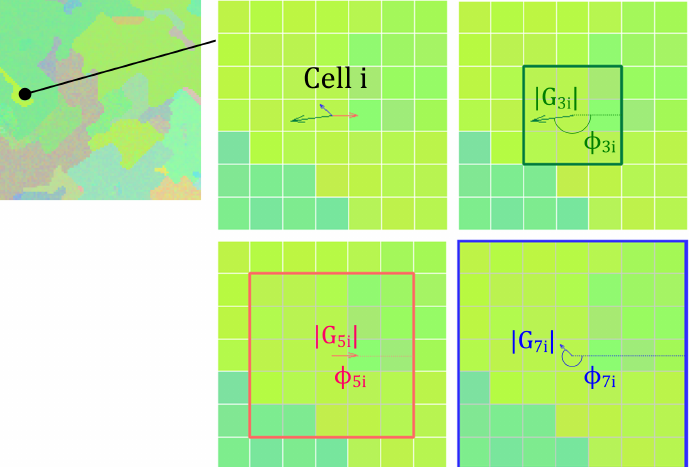
Figure 1. Extraction of the three gradient vectors, G N